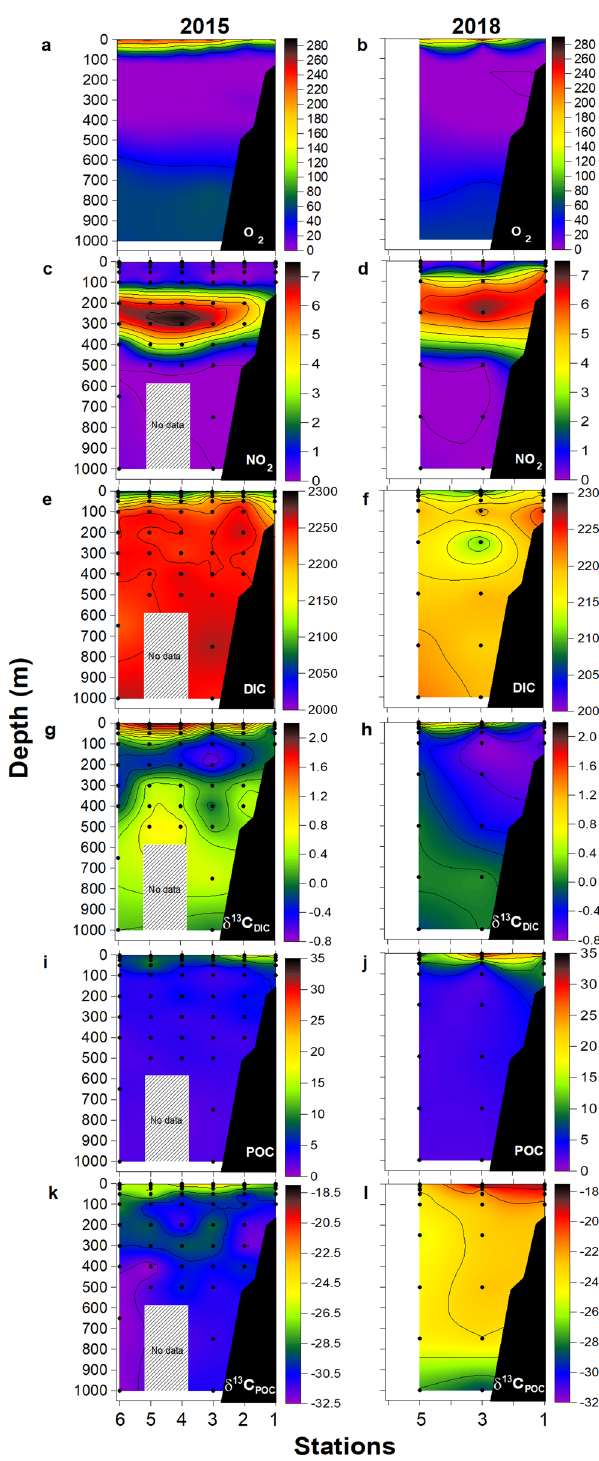
Fig. 3 Comparative conditions in 2015 vs. 2018 in a cross-shelf section off Iquique (20 °S). Vertical cross-shelf sections of oxygen, nitrite, dissolved inorganic carbon (DIC) and particulate organic carbon (POC) pools and their 13 C isotopic values during research cruises in 2015 and 2018. ( a , b ) Dissolved oxygen ( μ mol kg − 1 ), ( c , d ) nitrite ( μ mol kg − 1 ), ( e , f ) dissolved inorganic carbon ( μ mol kg − 1 ), ( g , h ) δ 13 C DIC ( ‰ ), ( i , j ) particulate organic carbon ( μ mol kg − 1 ), and ( k , l ) δ 13 C POC ( ‰ ). The black dots represent sample locations. Gray box represents area with non- collected